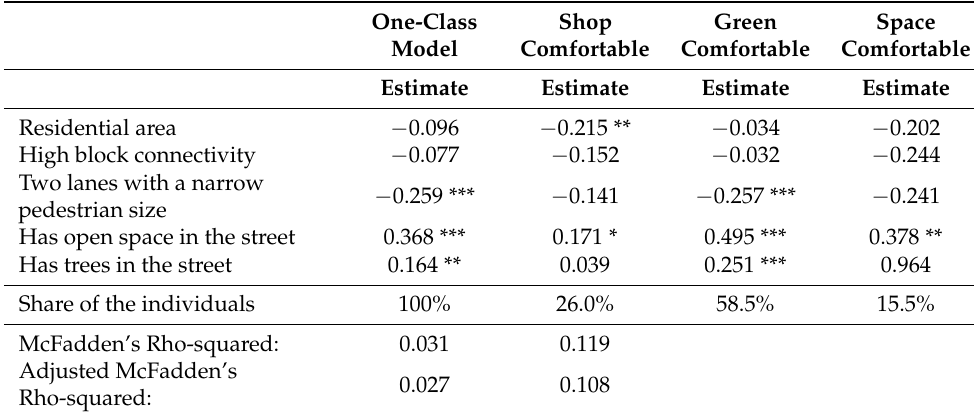
Table 7. Results for latent-class regression models ( comfortable sense